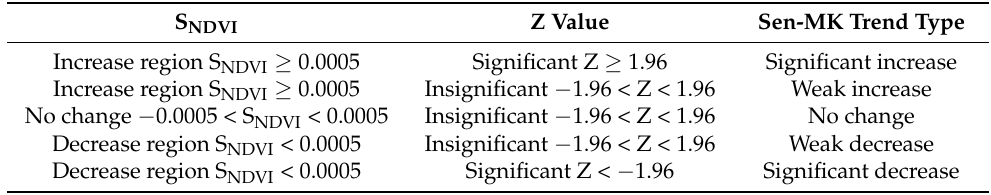
Table 2. Sen-MK trend type division. S NDVI Z Value Sen-MK Trend Type Increase region S NDVI ≥ 0.0005 Significant Z ≥